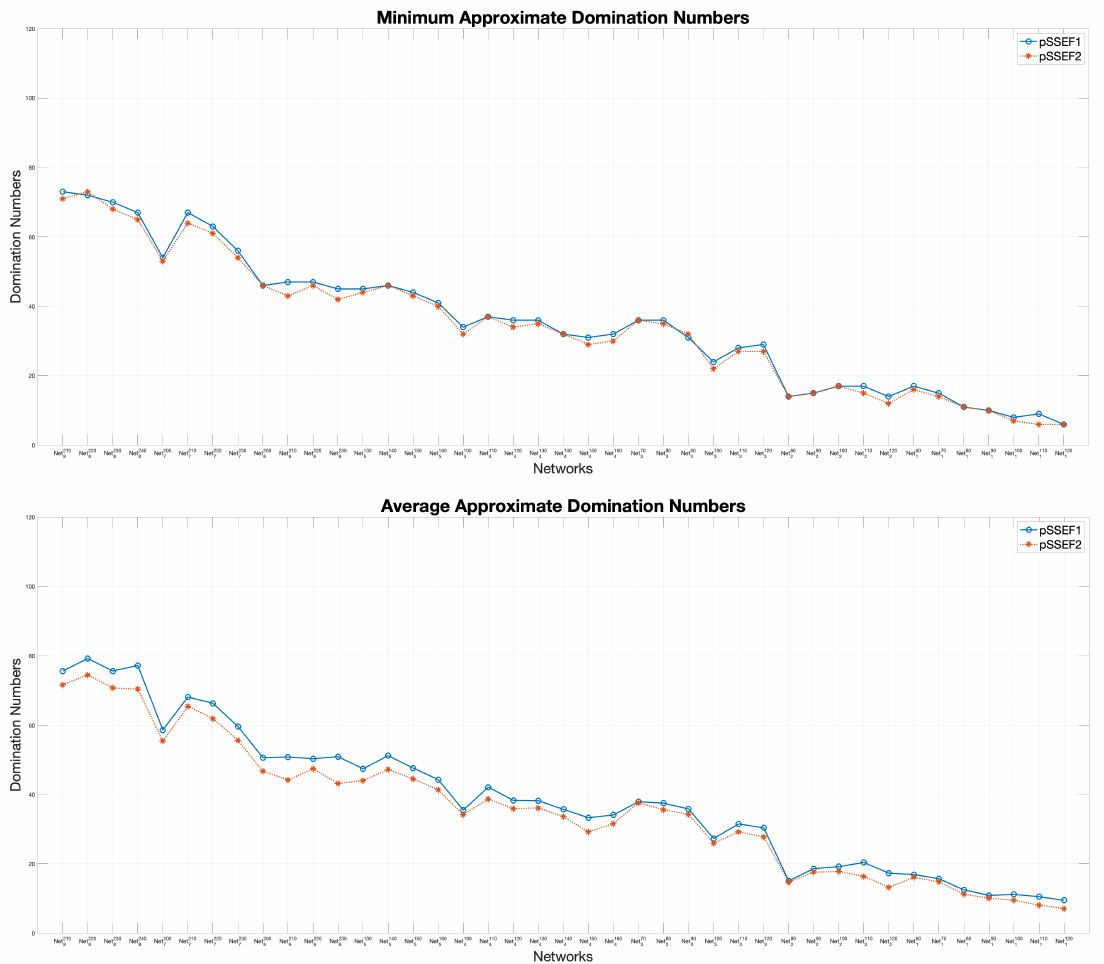
Figure 8. Performance comparisons between pSSEF1 and